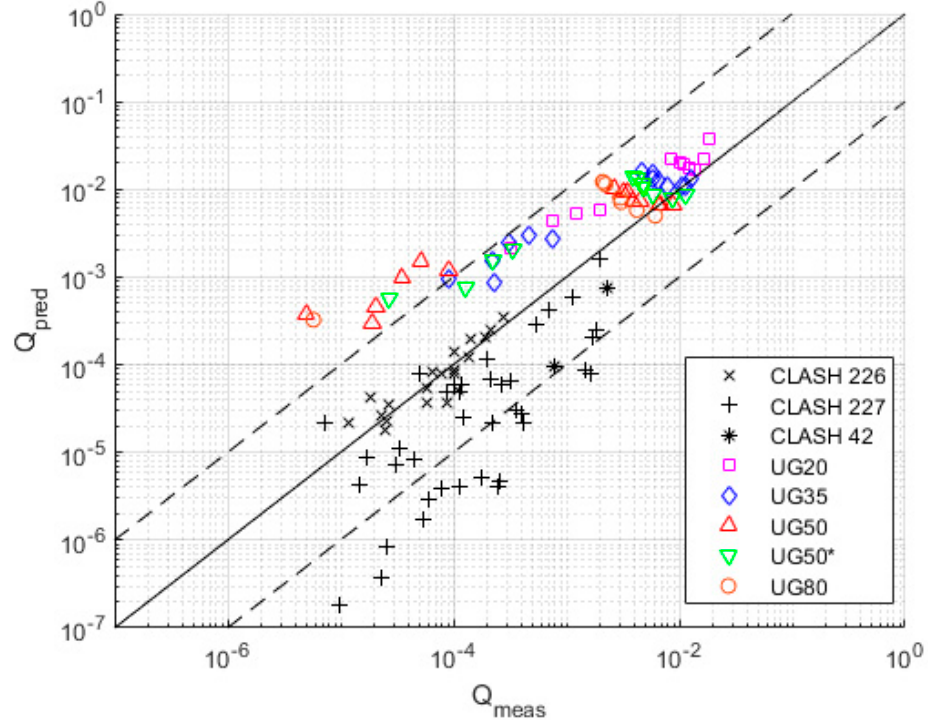
Figure 13. Measured versus predicted nondimensional overtopping discharge (by deep-water wave height) using the Lashley et al. [7] formula (solid line: prediction equal to measured rate; dashed lines: prediction equal to 10 times higher and lower than the measured rate).